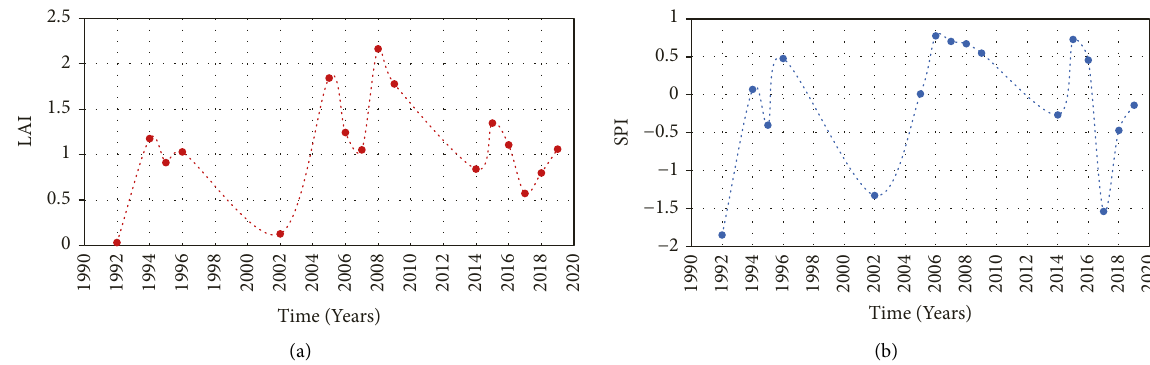
Figure 6: LAI was derived from the NDVI and SPI values over 29 years (1991–2019). (a) For LAI. (b) For